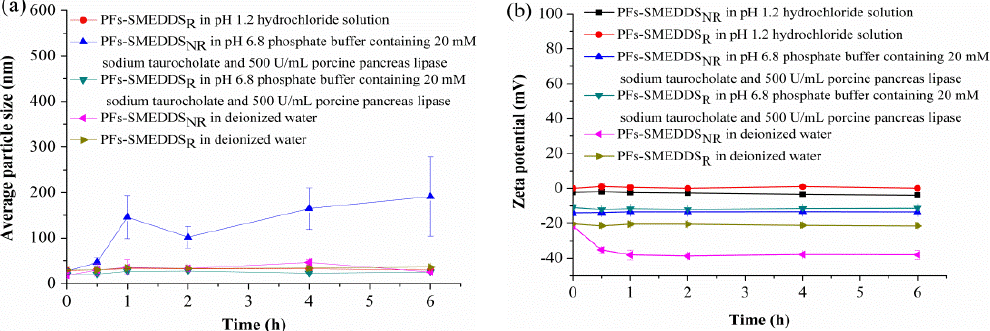
Figure 4. Effects of different media on average particle sizes ( a ) and zeta potentials ( b ) of PFs- SMEDDS NR and PFs-SMEDDS R (mean ± SD, n = 3).